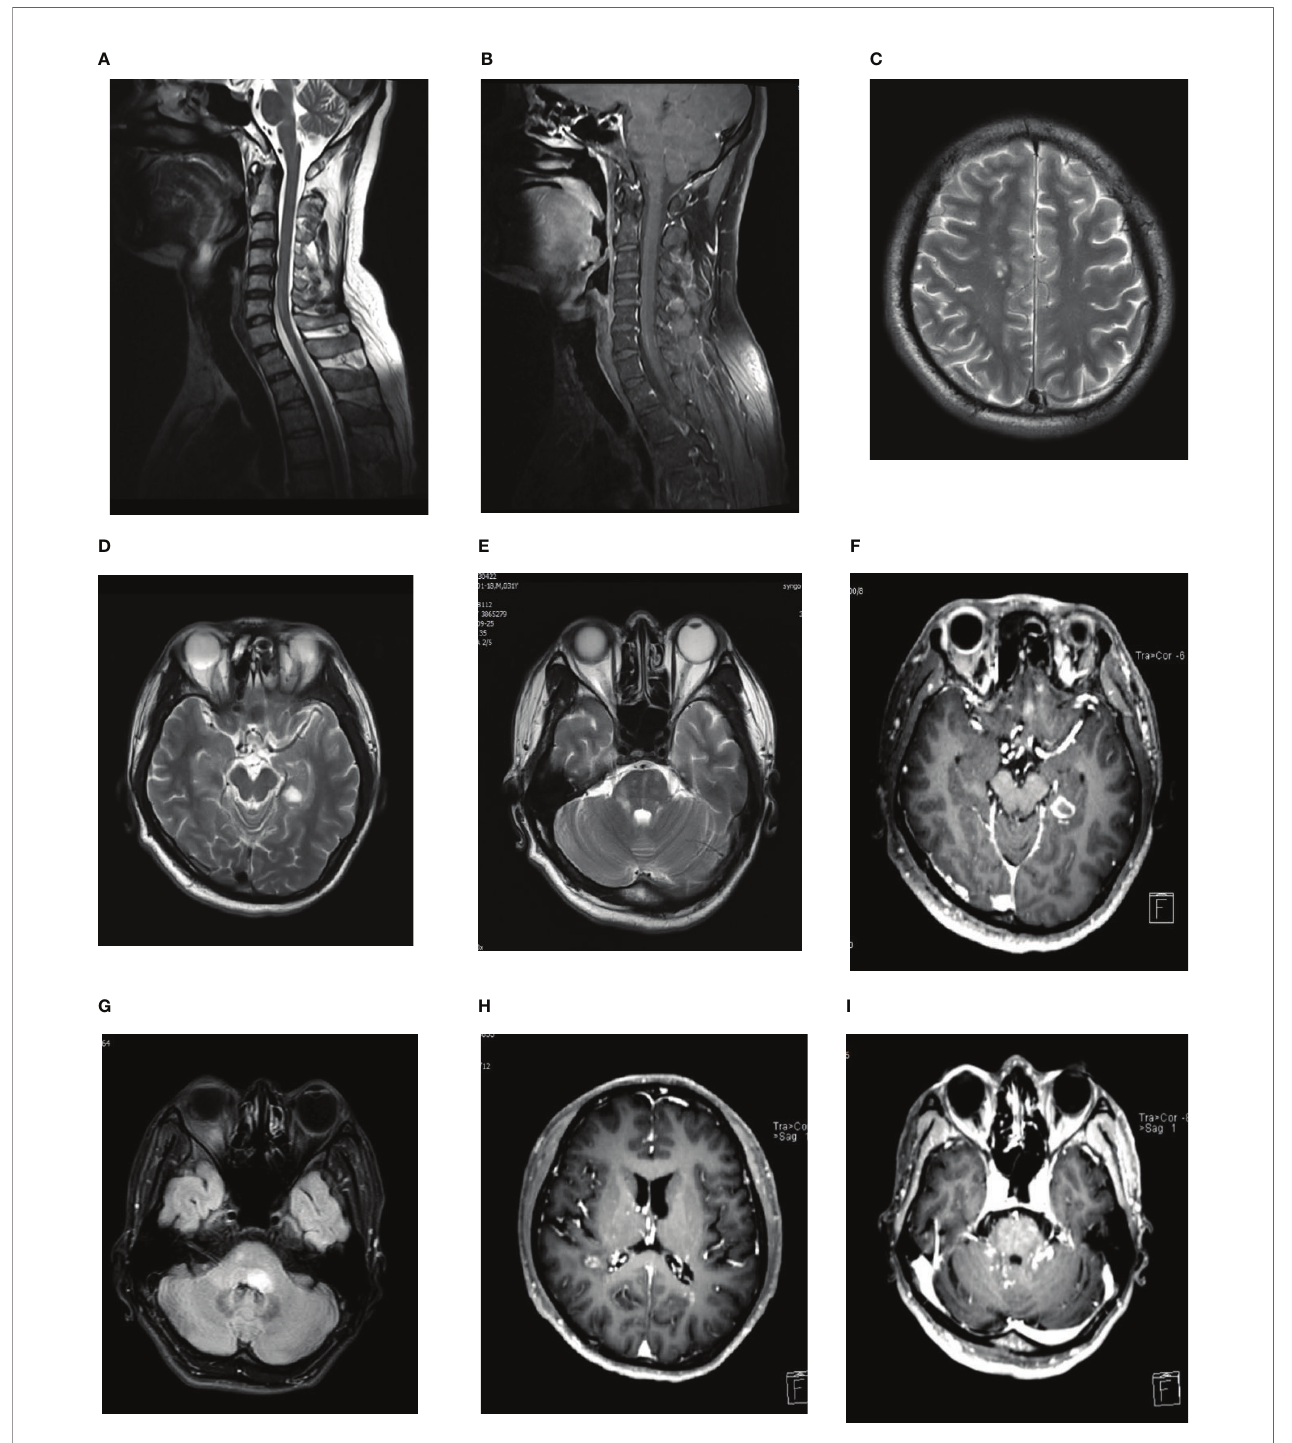
FIGURE 1 | (A, B) Spinal cord MRI showed T2-hypertense lesions at C5-6 (A) with slight Gd enhancement (B) . (C – F) Multiple lesions on MRI of the brain. T2- hypertense in right center semicovale, lateral paraventricular, pons, left temporal lobe, with an obvious contrast-enhancing lesions in the left temporal lobe. (G) Brain MRI revealed a new T2-hyperintense lesion located in left pons with no-contrast enhancement. (H, I) Gd-enhanced MRI showed punctate and curvilinear enhancing lesions involving the right semi-oval center areas, the anterior and posterior angles of lateral ventricle, pons and bilateral cerebellar hemisphere in the right hemispheres of hemispheres, the anterior and posterior angles of lateral ventricles, pons and left cerebellar hemispheres, without evidence of leptomeningeal